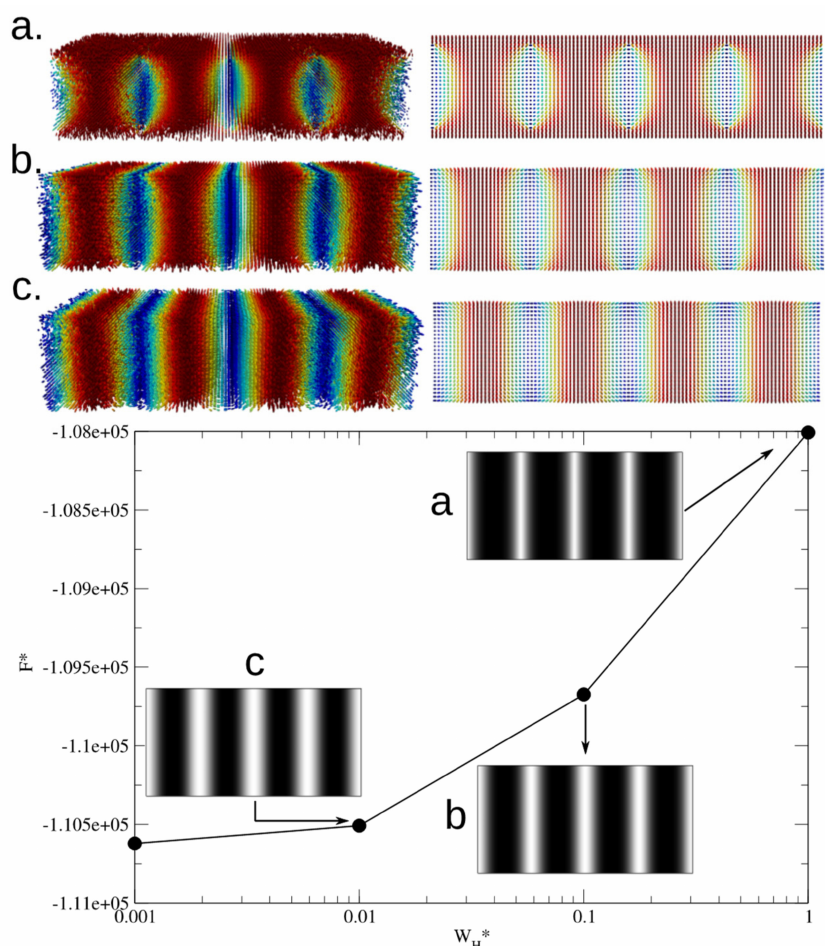
Figure 5. Simulations of a CLC confined in a homeotropic (top/bottom) channel. (Top) Images of the lying helical structure for different anchoring energies and the corresponding 2D lateral projections, ( a ) strong anchoring at both surfaces, ( b ) moderate anchoring, and ( c ) weak anchoring. The colormap goes from red to blue, where red is for parallel alignment and blue is for perpendicular alignment with respect to the z axis. (Bottom) Free energy as a function of the anchoring energy, and the insets correspond to cross-polarizer